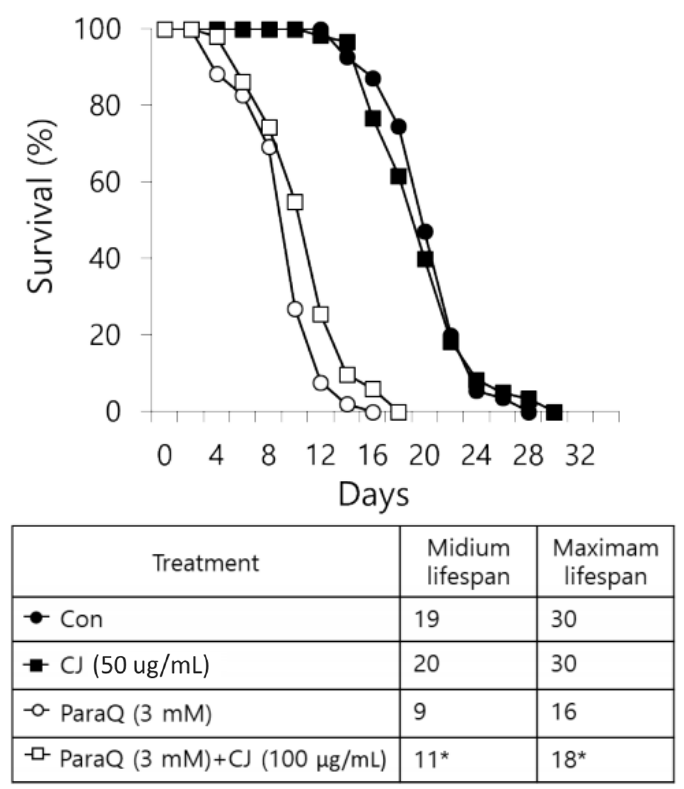
Figure 5. Survival curve of C. elegans treated with CJ extracts under normal and oxidative stress conditions. C. elegans were treated with CJ extracts (50 µ g / mL) starting from young adult (day 0) and the survivals were recorded every other day until all the worms died. Oxidative stress was induced by 3 mM paraquat (paraQ). n = 3 plates and 100–120 worms/group.